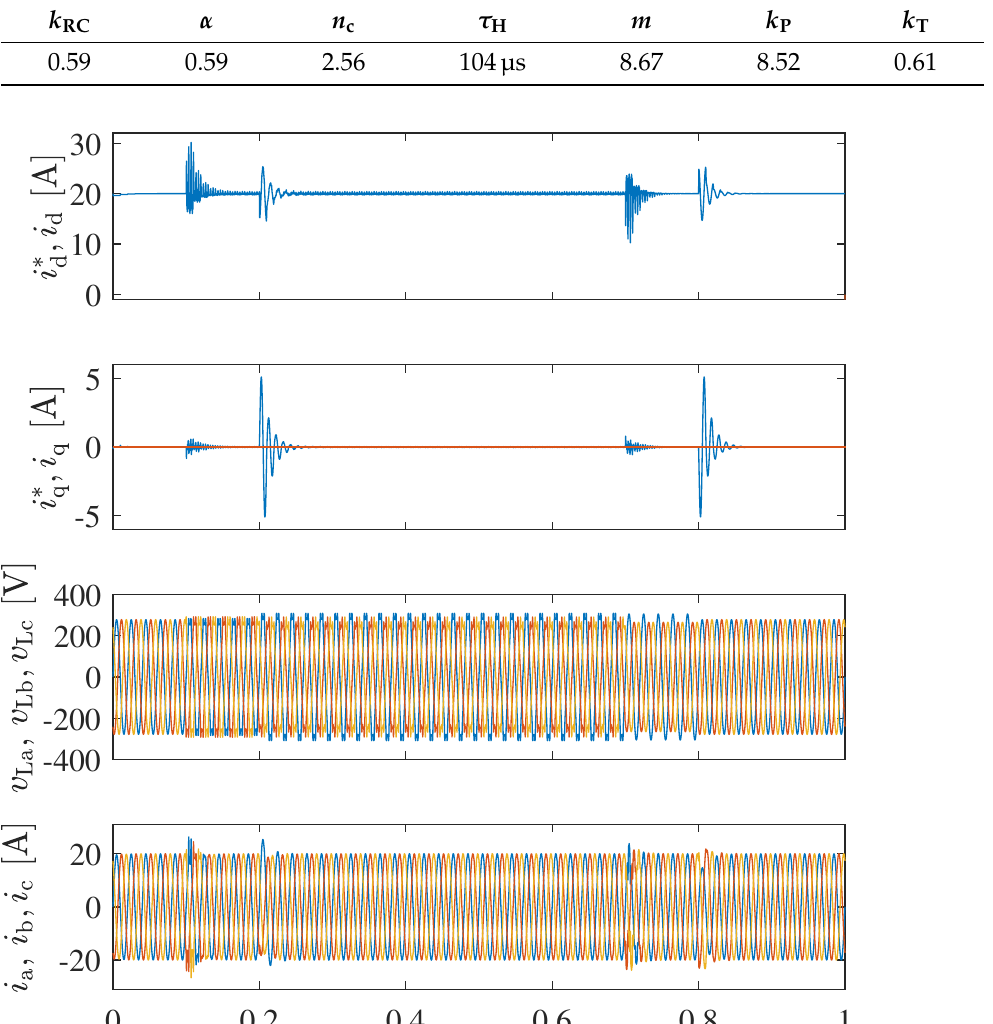
Table 2. Parameters of the current control system achieved in the optimization process.